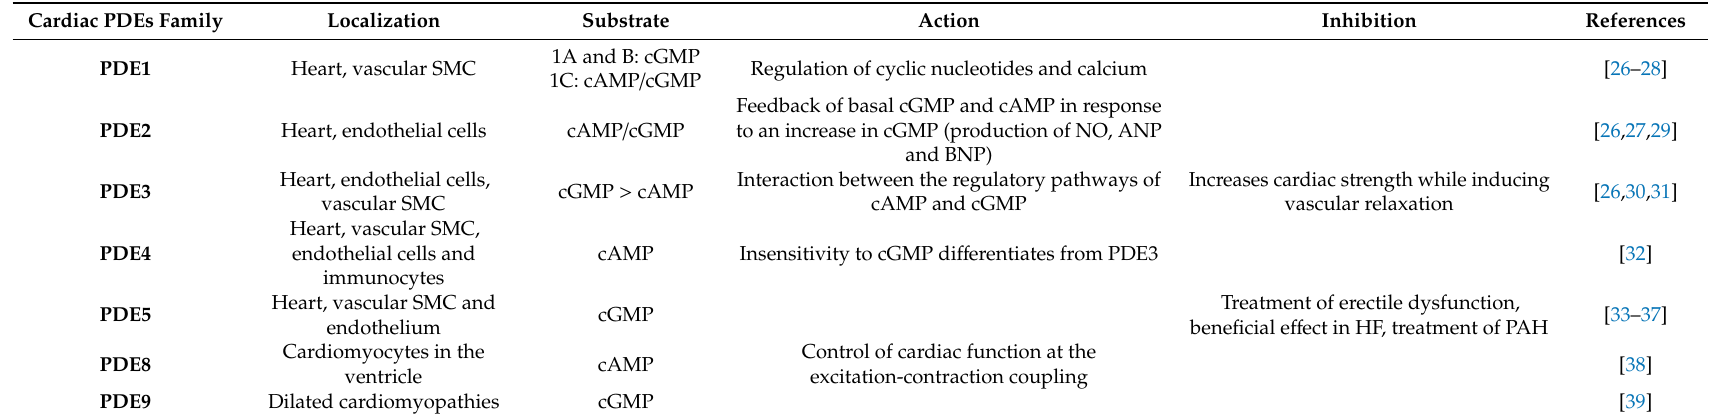
Table 1. Cyclic nucleotide phosphodiesterases